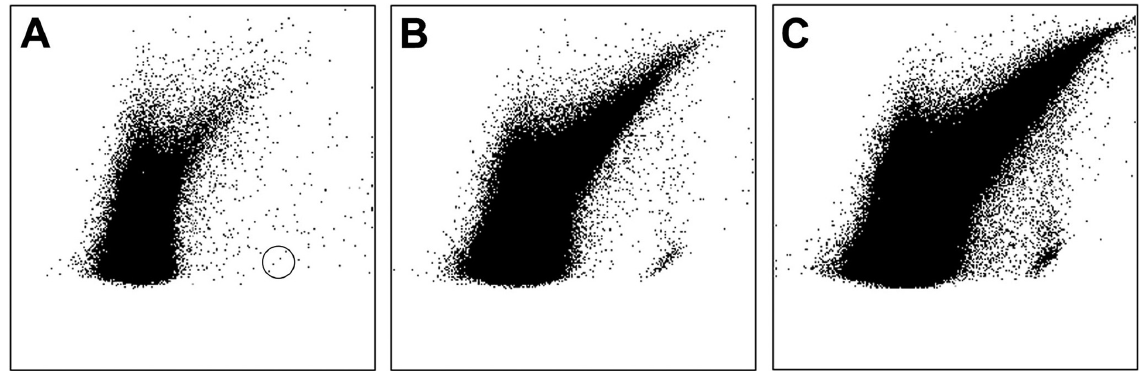
Figure 6 . Effects of tangential fl ow fi ltration (TFF) on assay sensitivity. Alfalfa sprouts were spiked with 10 4 CFU g (cid:1) 1 S. Typhimurium and were homogenized in 0.1% peptone water as described in Materials and Methods, then either processed directly for FISH and fl ow cytometry, or fi rst subjected to additional concentration steps via TFF ( ∼ 10x concentration) or TFF plus centrifugation (2,000 (cid:1)